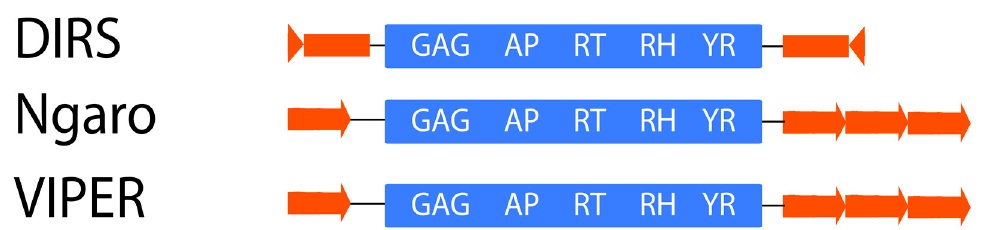
Figure 5. Structure of Dictyostelium intermediate repeat sequences (DIRS).